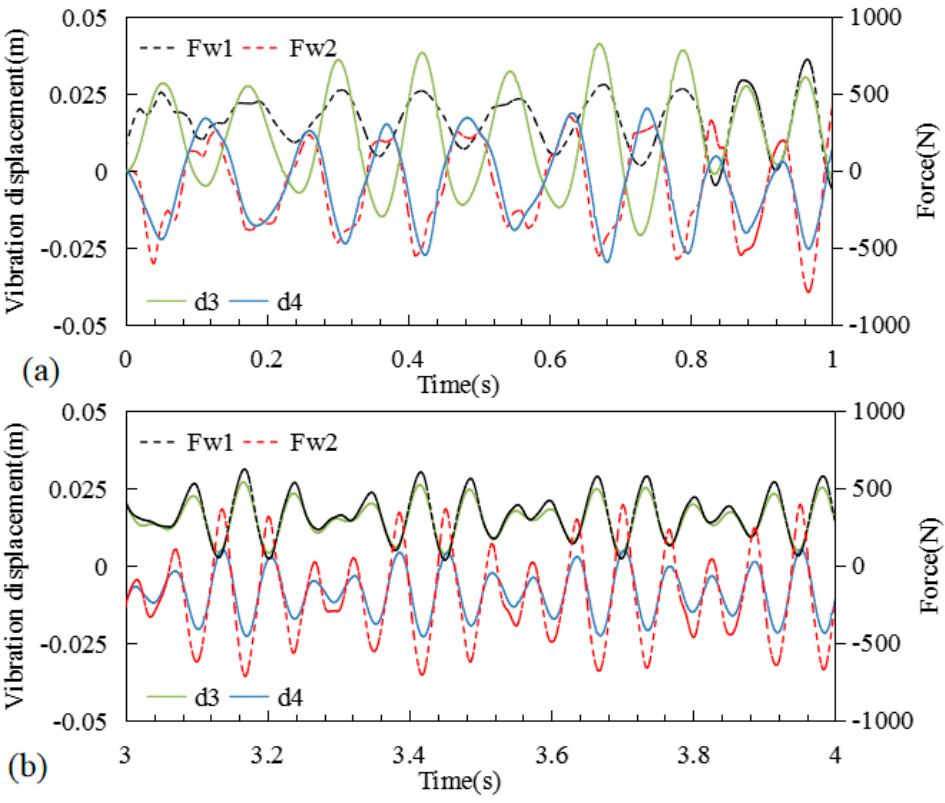
Figure 16. The relationship between displacement and resultant force in the initial and stable stages of vibration: ( a ) initial stage of vibration, ( b ) stable stage of vibration.